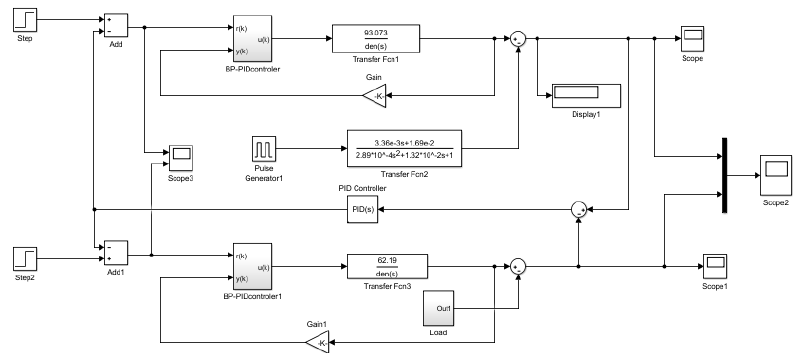
Figure 17. BP self-tuning PID simulation model.